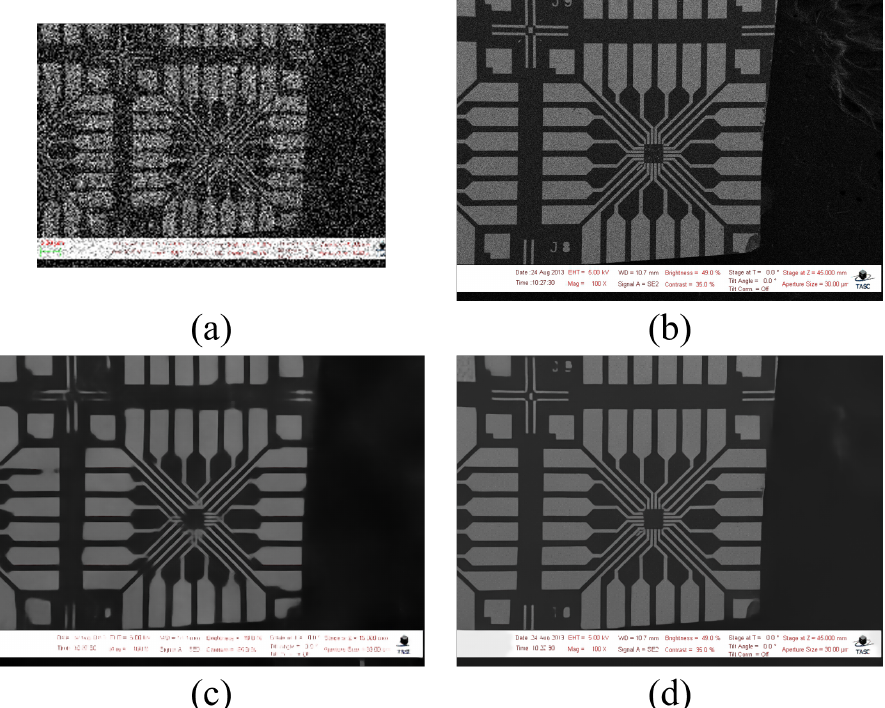
Figure 2. Limitations of applying naive SR methods: ( a ) input LR image, ( b ) target HR image, ( c ) output of naive inference of SwinIR method, and ( d ) output of proposed scheme on